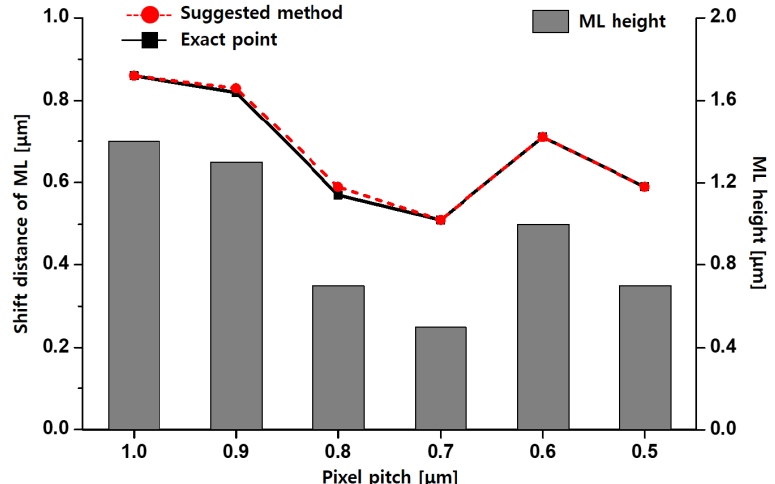
Figure 3. Comparison of simulation results and calculation results with the changed shift distance of microlens (ML) according to microlens height at CRA 35°.